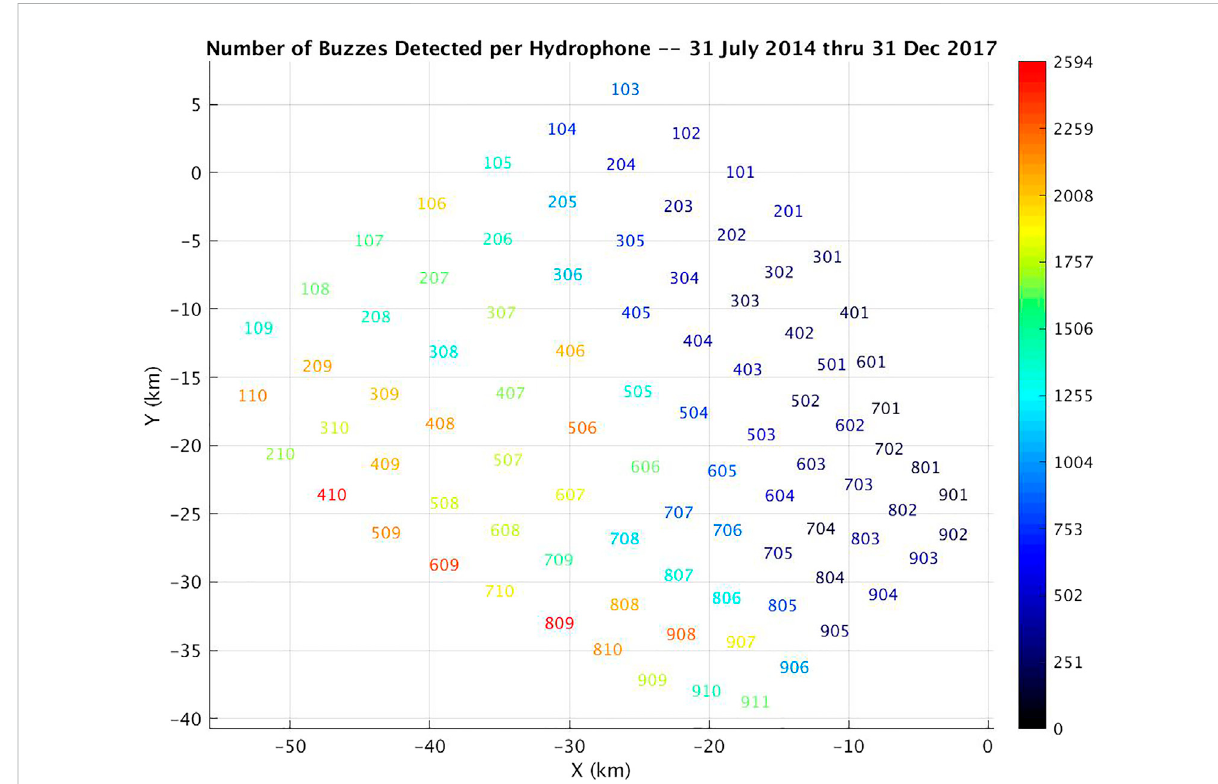
FIGURE 8 Number of buzzes detected per hydrophone at SOAR from 31 July 2014 to 31 December 2017.